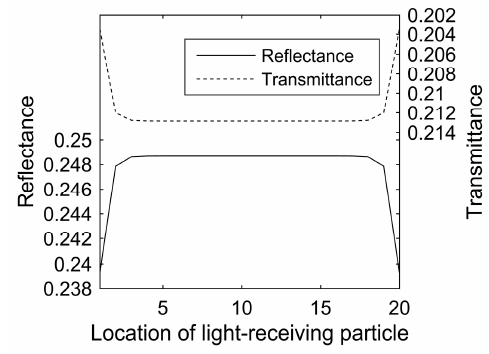
Figure 9. A typical relationship between reflectance R ( N , i , n , α d , x u , x d ) and transmittance T ( N , i , n , α d , x u , x d ) and location of the entrance particle i . N is the total number of particles, n is the refractive index, α d is the diametrical absorbance, x u and x d are the particle backscattering and forward scattering ratios, respectively. All other parameters were set to constants i.e., R ( 20, i ,1.45,0.5,0.3,0.4 ) .